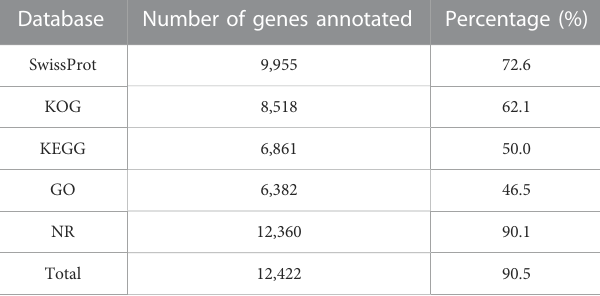
TABLE 4 Annotation summary of the predicted protein-coding genes residing inthe S.montelus genomeintheSwissProt,KOG,KEGG,GO,andNRdatabases.